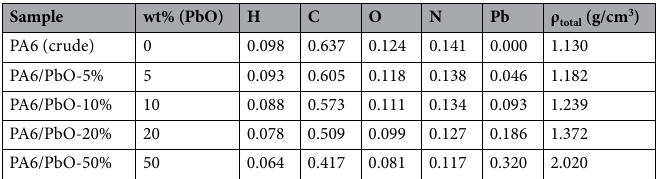
Table 1. Characteristics of the studied composites with five different PA6 and PbO